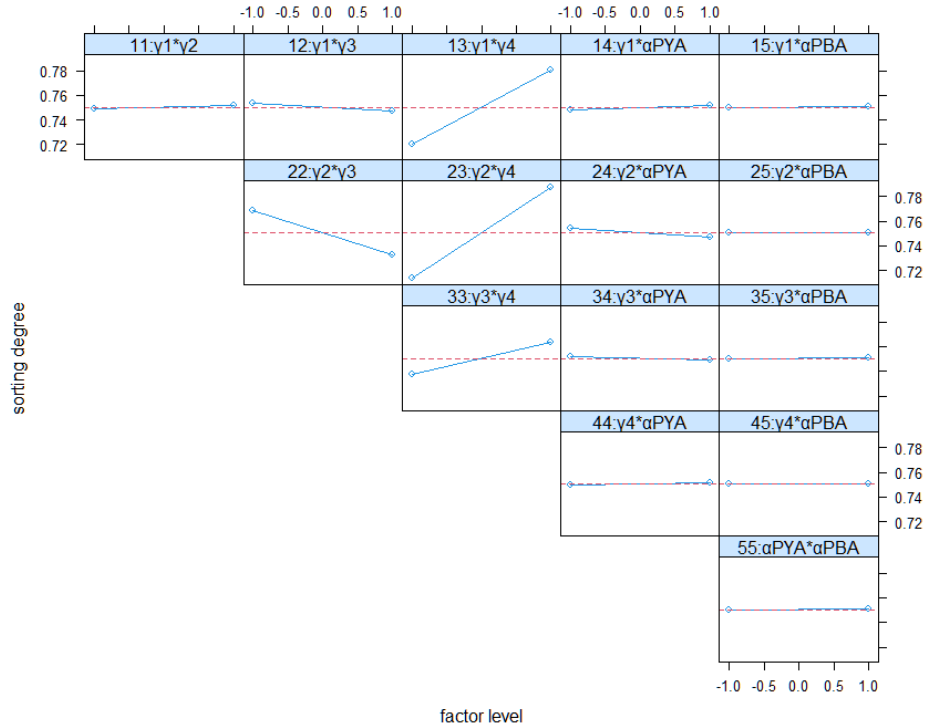
Figure 10. Factor interactions for sorting degree in the generic scenario.